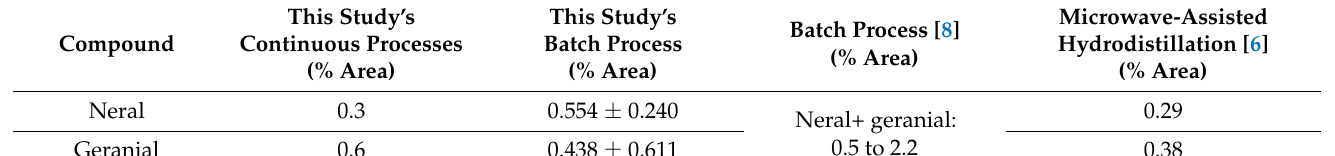
Table 4. Content of citral isomers (neral and geranial) in Persian lime.